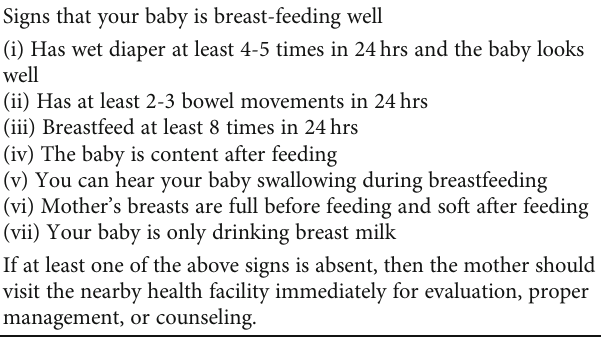
If at least one of the above signs is absent, then the mother should visit the nearby health facility immediately for evaluation, proper management, or